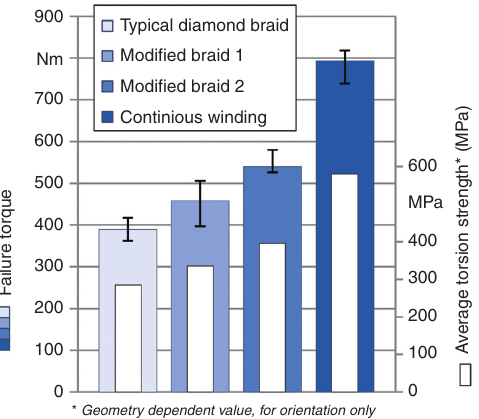
Figure 16 Torsional strength of specimens with different textile patterns.